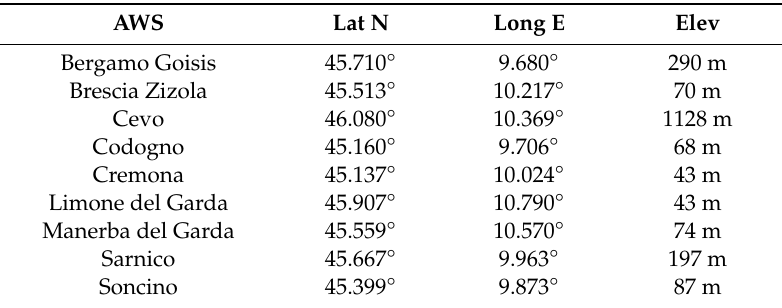
Table 1. Geographical features of the analyzed meteorological stations